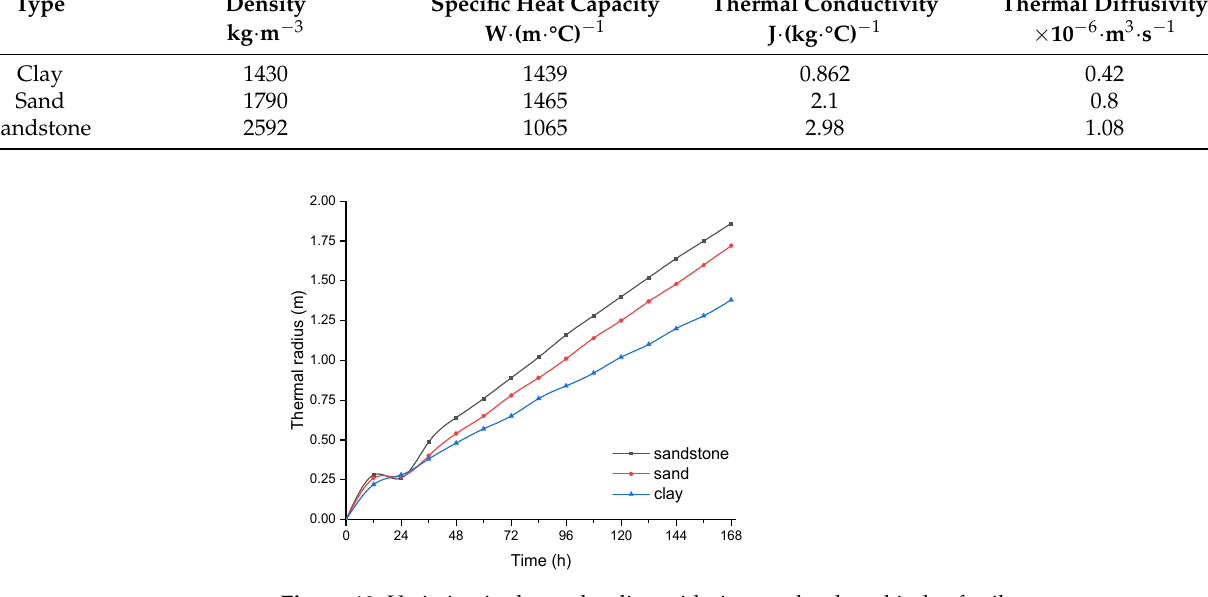
Figure 10. Variation in thermal radius with time under three kinds of soil types.